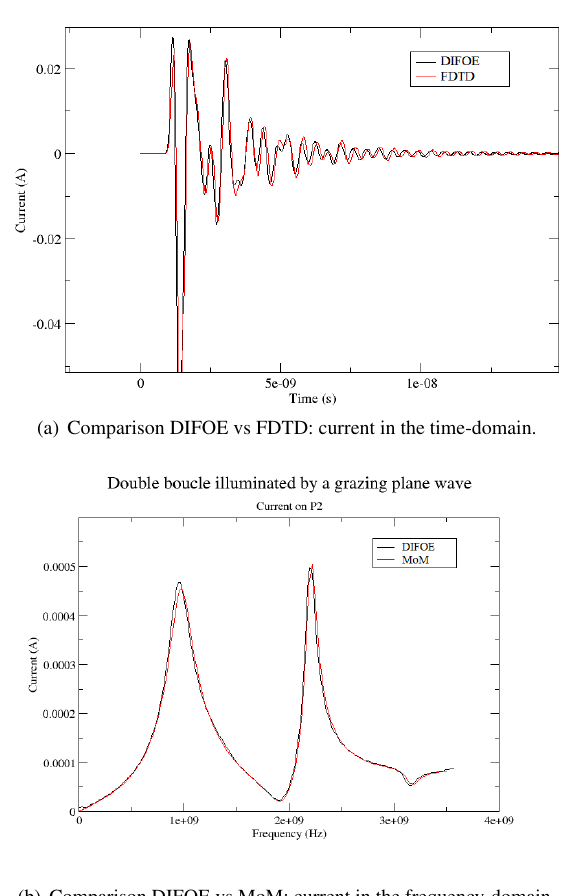
Figure 10: Comparisons of the solution obtained with our method and MoM.